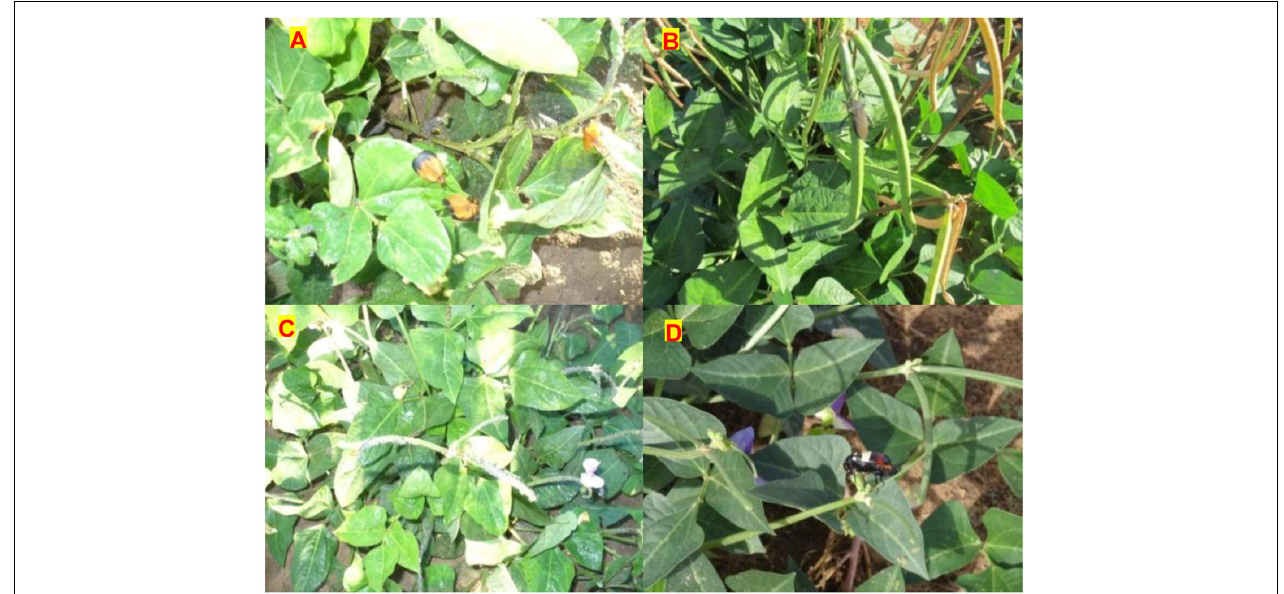
FIGURE 6 | Common insect pests (A) Spiny brown bugs Clavigralla sp., (B) Coreid bug Anoplocnemis curvipes , (C) Aphids Aphis craccivora Koch and Blister (D) Beetle Mylabris phalerata observed among the M 5 mutants at Bagani, and Omahenene Research Stations concurrently.